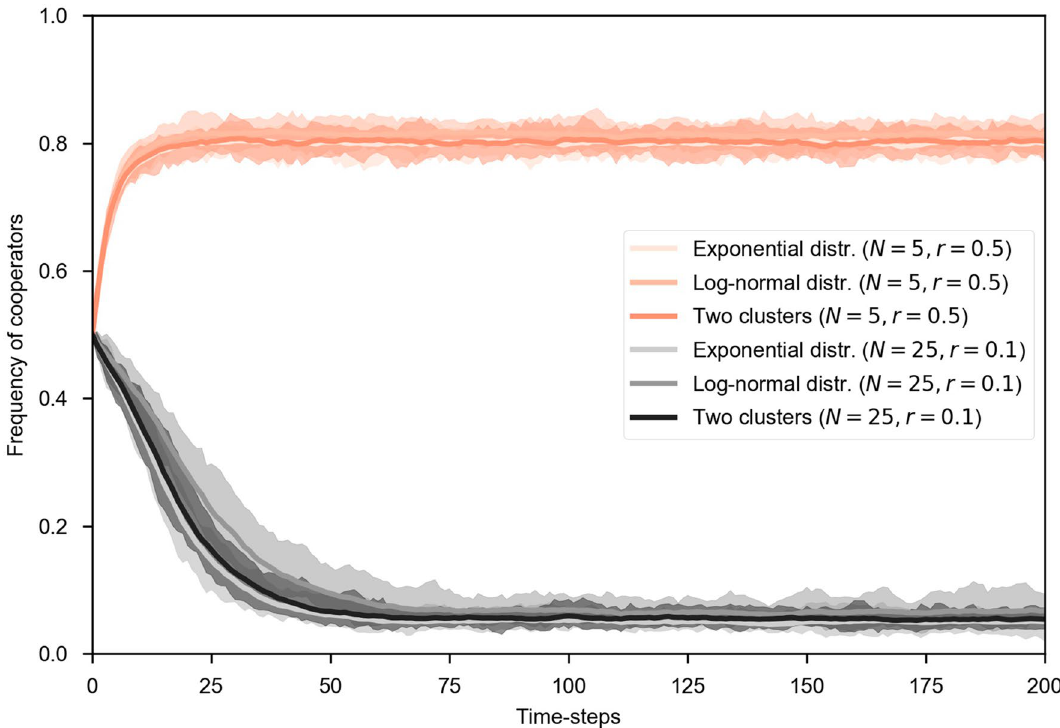
Figure 3. Evolution of the tourism dilemma using heterogeneous costs for the regions (players) for different risk r values and group sizes for 200 time steps. The solid line is the average of the MC runs and the semi- transparent region denotes the maximum and minimum values obtained in these 30 MC